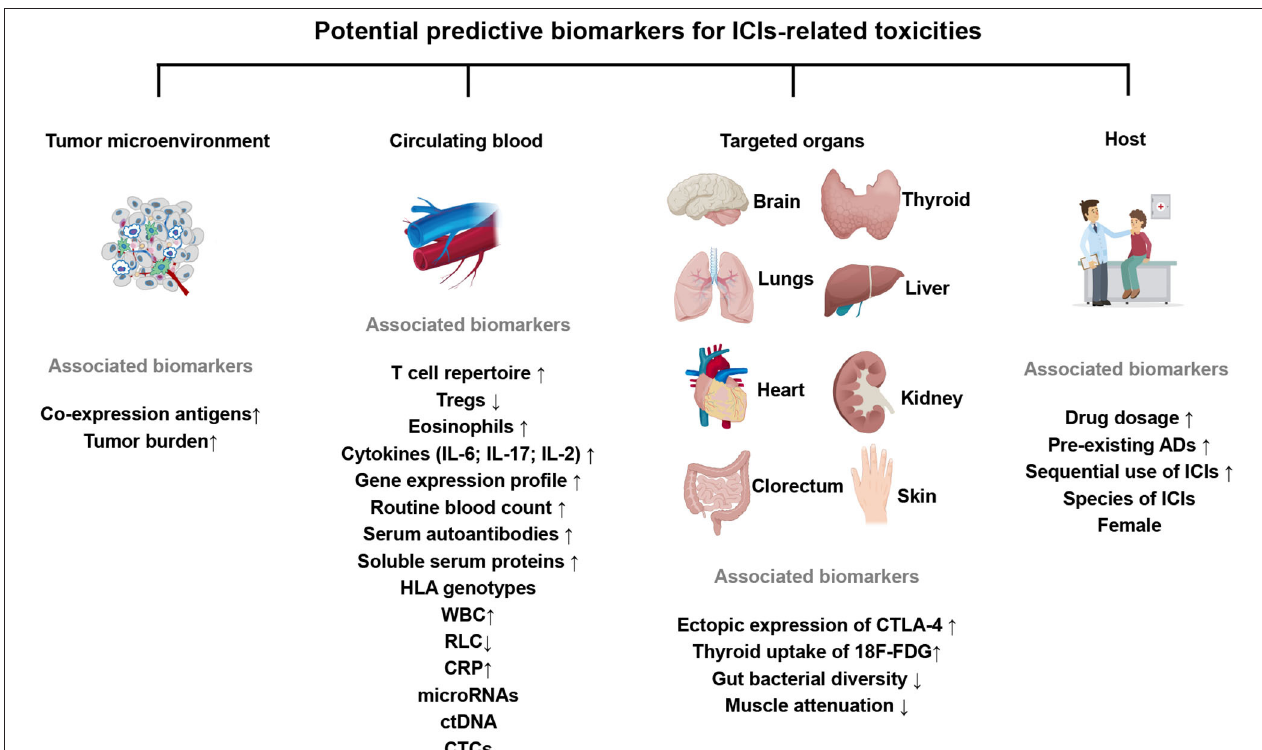
FIGURE 2 | Expression of key potential biomarkers from the tumor microenvironment, circulating blood, target organs or clinical factors, predictive for ICIs-related toxicities. The up or down arrows represent the increase or decrease of biomarkers. All these factors are associated with an increased incidence of ICIs-related toxicities. ICIs, immune checkpoint inhibitors; Tregs, regulatory T cells; IL-6/17/2, Interleukin-6/17/2; HLA, human leukocyte antigen; WBC, white blood cells; RLC, relative lymphocytes count; ctDNA, circulating tumor DNA; CTCs, circulating tumor cells; 18F-FDG, 18F-fluorodeoxyglucose; CRP, C-reactive protein; CTLA-4, cytotoxic T lymphocyte-associated antigen-4; pre-existing ADs, pre-existing autoimmune